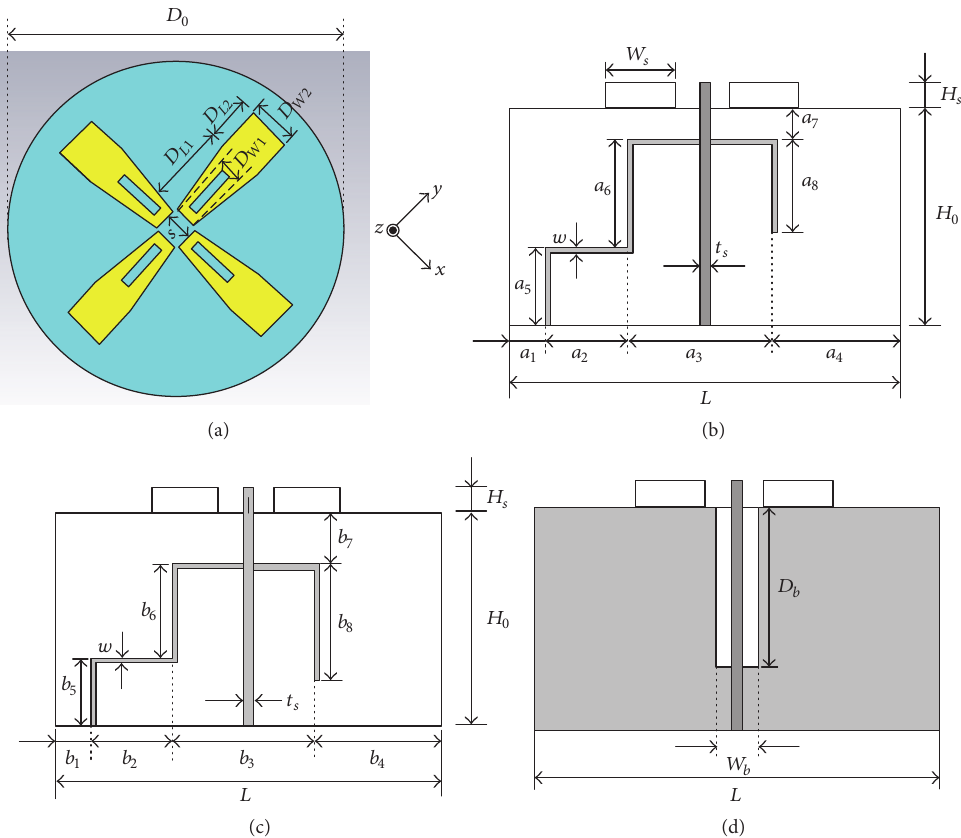
Figure 3: Design parameters of the crossed dipoles. (a) Crossed dipoles, (b) the dipole feed circuits for RHCP, (c) the dipole feed circuits for LHCP, and (d) the backside of the feed circuits for RHCP and LHCP.